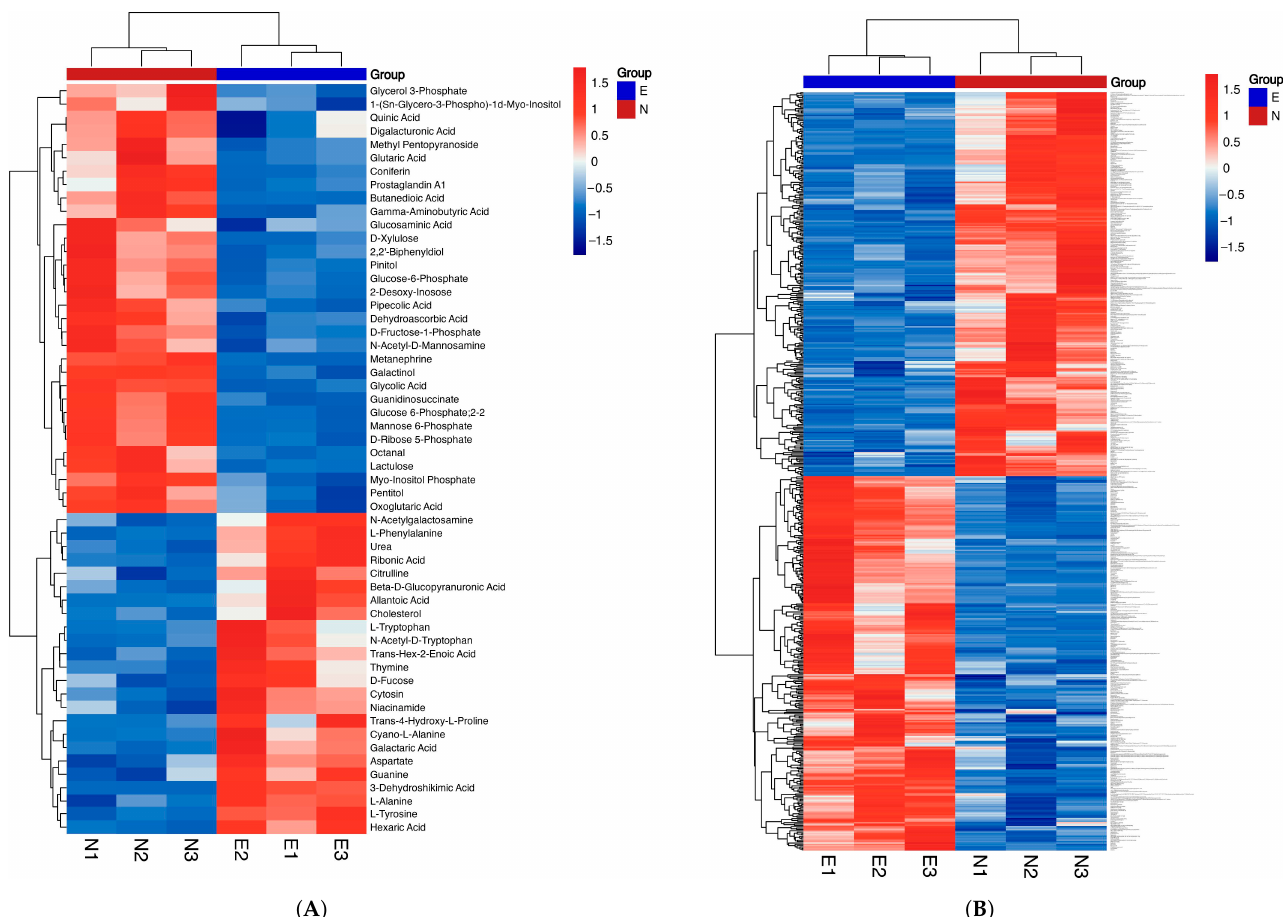
Figure 6. Hierarchical clustering of the differentially abundant metabolites based on GC-MS ( A ) and both the positive and negative ion modes based on LC-MS ( B ) between healthy leaves (N1, N2, N3) and damaged leaves of E. onukii (E1, E2, E3). The data were log2 transformed, and similarity assessment for clustering was based on the Euclidean distance coefficient and complete clustering algorithm. Columns and rows represent individual metabolites and different samples respectively.